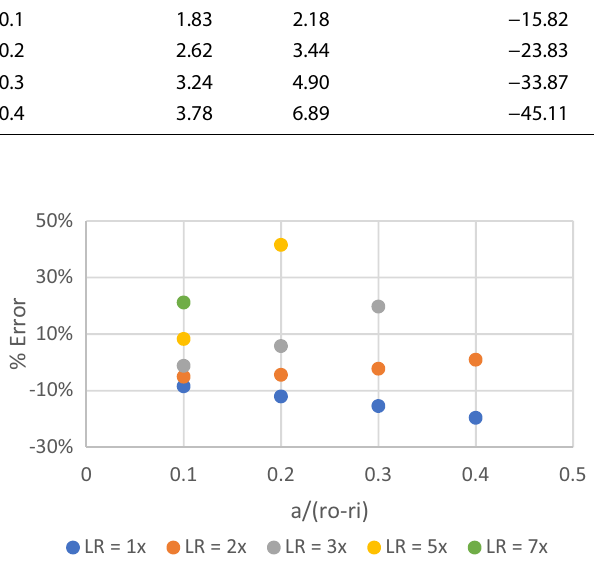
Fig. 17 Error in stress intensity factors for pressure vessel configura- tion 1